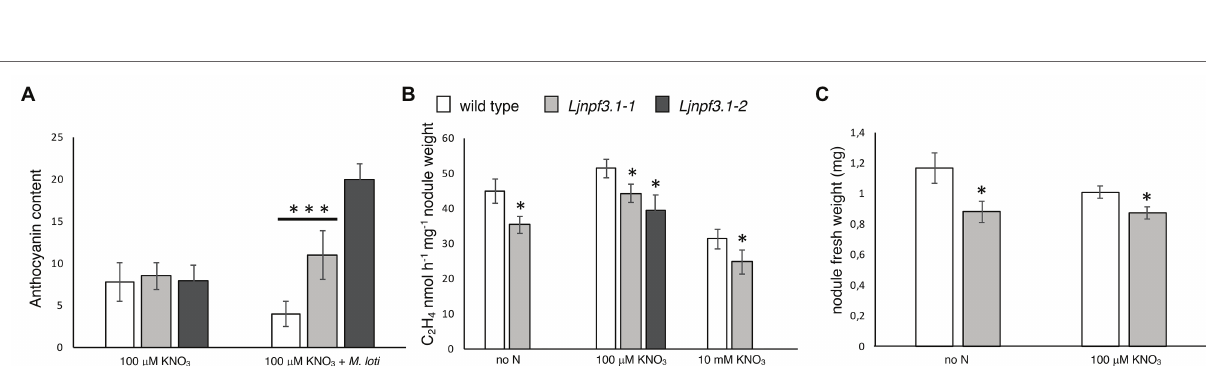
FIGURE 5 | Phenotypic characterization of Ljnpf3.1-1 and Ljnpf3.1-2 mutants. Wild-type and Ljnpf3-1 plants, inoculated with M. loti and grown in the presence of different concentrations of KNO 3 . (A–C) Plants grown in Petri dishes, axenic conditions, scored 4 weeks after inoculation. (D–F) Plants were grown in pots scored at 6 weeks after inoculation. (A,D) Nodules number per plant. (B,D) Shoots length per plant. (C,F) Shoots fresh weight per plant. Different KNO 3 regimes and plant genotypes are indicated [noninoculated plants in panels (E,F) are indicated by oblique-filled bars]. Bars represent the means and SE of measures from three experiments (at least 20 plants per experiment per condition). Asterisks indicate significant differences with wild-type levels. ∗ p < 0.05; ∗∗ p < 0.002; and ∗∗∗ p < 0.0001.